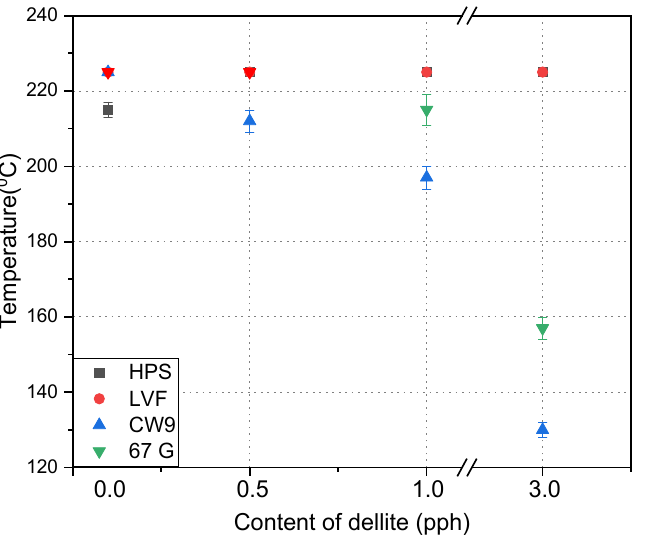
Figure 7. Effect of contents of dellite addition on the maximum work temperature of silicone pressure-sensitive adhesives.